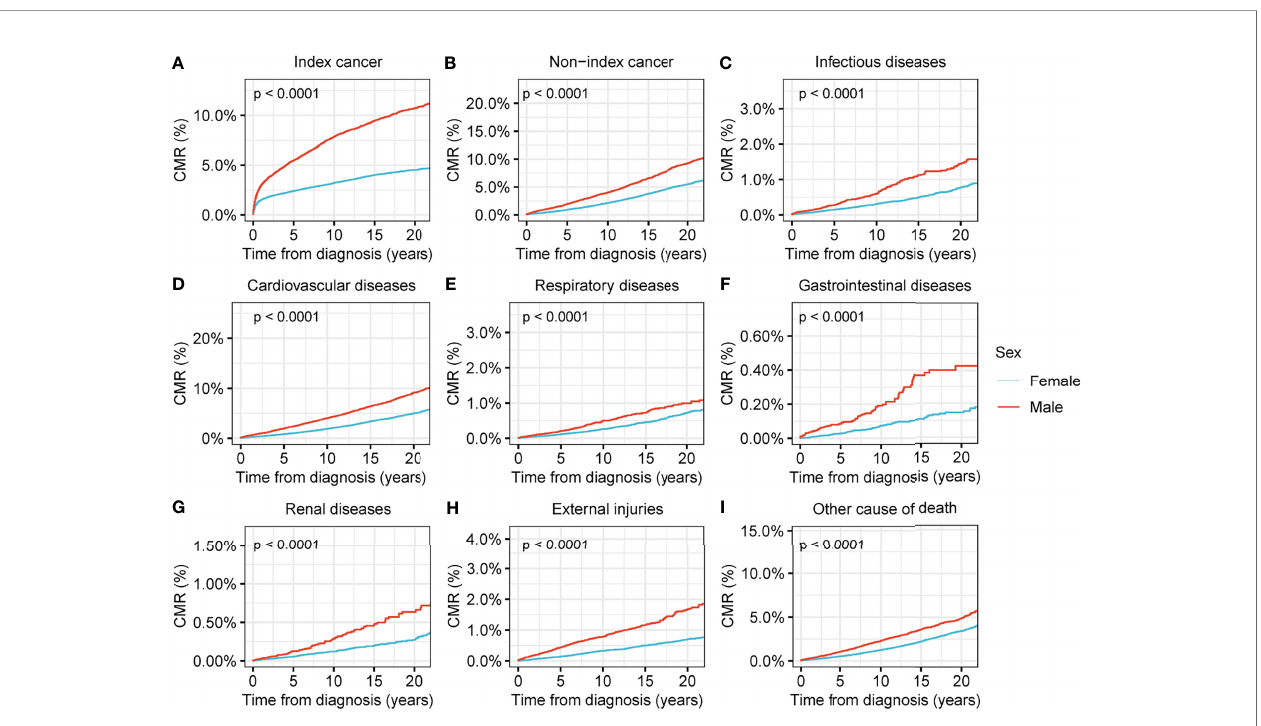
FIGURE 3 | Cumulative mortality rate (CMR) among patients with thyroid cancer by sex. (A) CMR from index cancer among patients with thyroid cancer by sex. (B) CMR from non-index cancer among patients with thyroid cancer by sex. (C) CMR from infectious diseases among patients with thyroid cancer by sex. (D) CMR from cardiovascular diseases among patients with thyroid cancer by sex. (E) CMR from respiratory diseases among patients with thyroid cancer by sex. (F) CMR from gastrointestinal diseases among patients with thyroid cancer by sex. (G) CMR from renal diseases among patients with thyroid cancer by sex. (H) CMR from external injuries among patients with thyroid cancer by sex. (I) CMR from other non-cancer causes among patients with thyroid cancer by